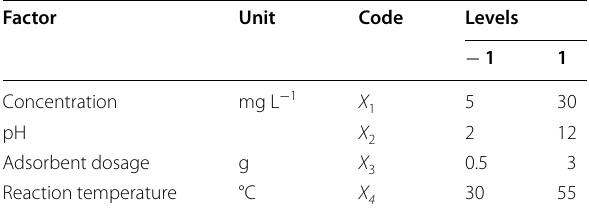
Table 1 List of independent variables and